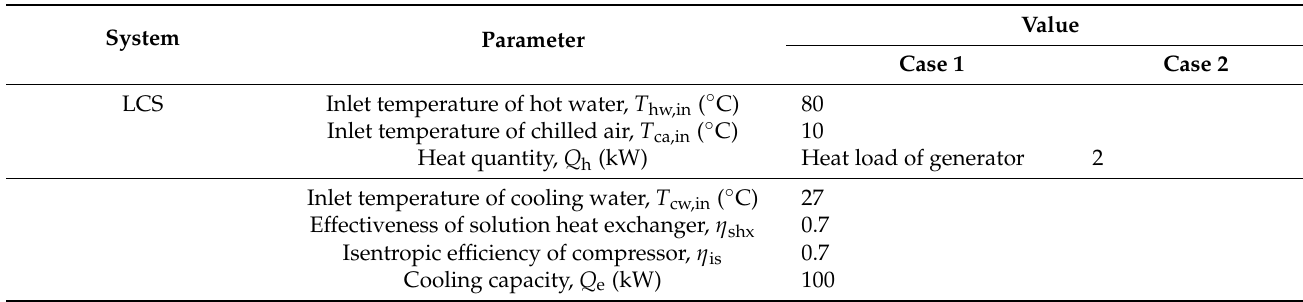
Figure 5. Effect of intermediate temperature on performance indicators for the layout with a cascade condensation process in case 1.